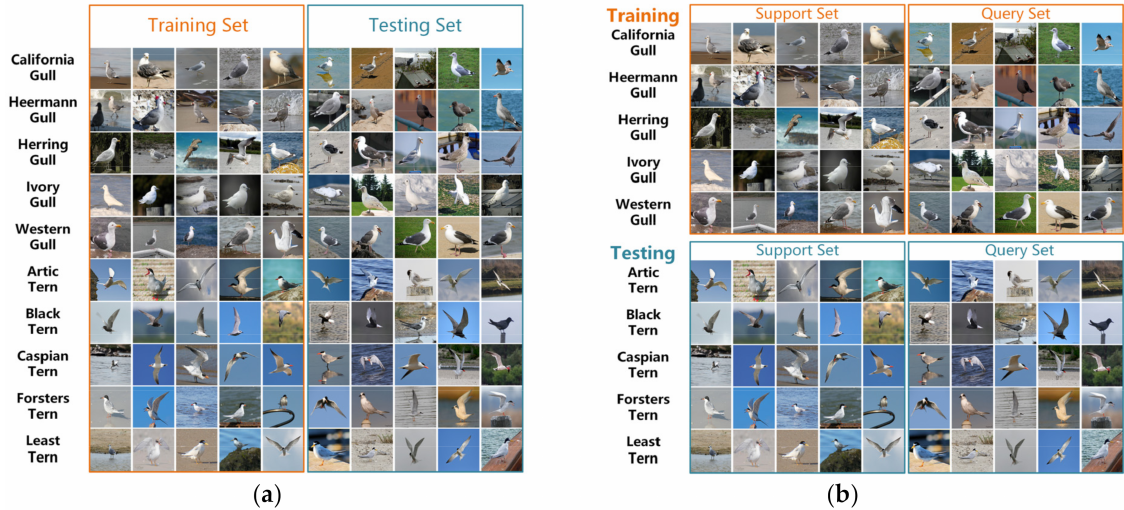
Figure 2. Few-shot tasks and traditional image classification tasks in CUB-200-2011 dataset: ( a ) tradi- tional classification; ( b ) few-shot